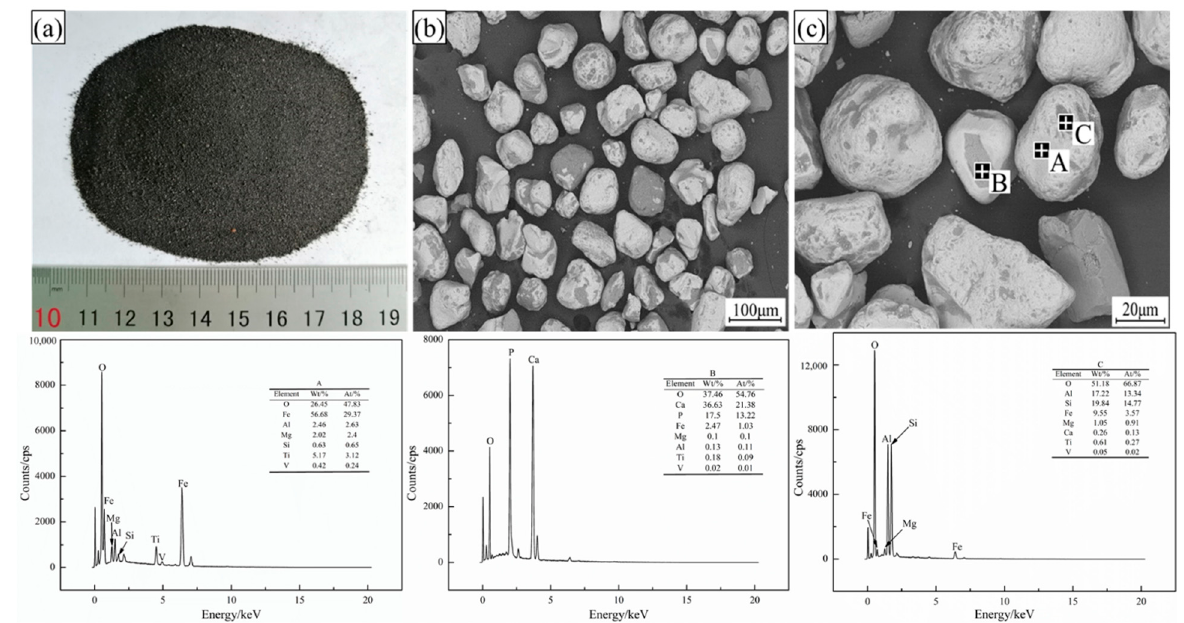
Figure 2. Structure of the sea sand ore: ( a ) Original state; ( b ) 200×; ( c ) 500× A Mastersizer 3000 laser particle size analyzer (Mastersizer 3000; Malvern, UK) was used to analyze the particle size composition of the three raw materials, and the results are shown in Figure 3. It can be seen from the particle size distribution diagram that the particle size of the sea sand ore was coarsest, followed by Yuantong-14, and Sijiaying ore was the finest. Among them, the particle size distribution of the large part of the sea sand ore was about 144 μ m, and the particle size of Sijiaying and Yuantong-14 was relatively fine, most of which were distributed around 52 μ m and 67 μ m, respectively.